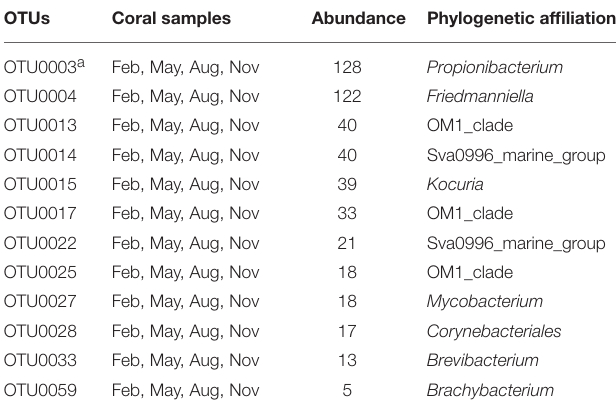
TABLE 2 | OTUs presented in all of the coral and seawater libraries, or presented in all three divergent compartments of P. lutea . OTUs